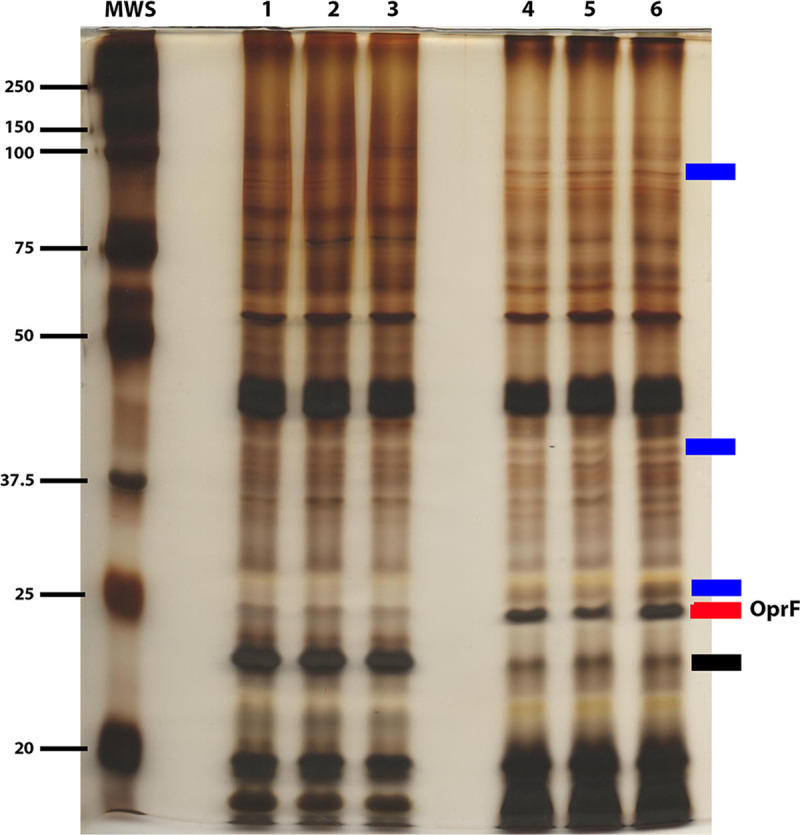
Growth of PAO1 in 10% PHS altered the production of outer membrane proteins.PAO1 was grown in either LBB or LBBS for 16 h post-inoculation. Samples were harvested, lysed, and enriched for OMPs. Samples containing 50 μg of OMPs were separated by SDS-PAGE and stained with silver stain. Lanes: MWS, (molecular mass standards); 1–3, OMPs from PAO1 grown in LBB; 4–6, OMPs from PAO1 grown in LBBS. Blue and red bars, proteins enhanced by growth in LBBS; red bar, OprF; black bar, protein reduced by growth in LBBS.